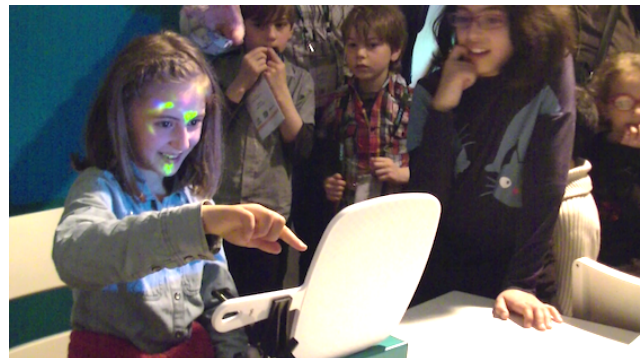
Fig. 12. SharedFace during a demonstration at Laval Virtual